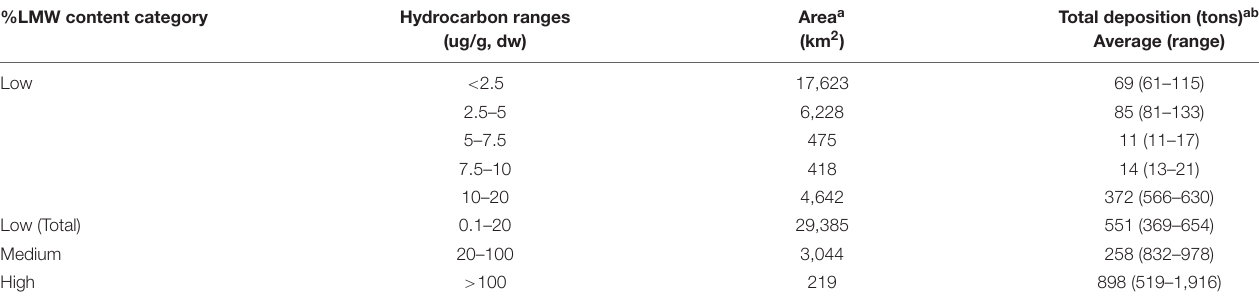
TABLE 2 | Area coverage and total deposition of oil residues calculated in Romero et al. (2017) for each %LMW category and hydrocarbon